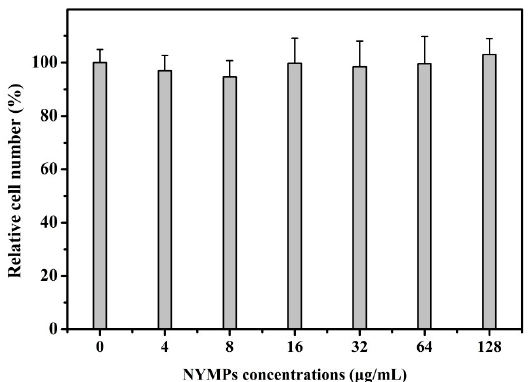
Figure 1. Cytotoxicity of water-soluble NYMPs on human breast cancer MCF-7 cells under different concentrations. Each value represents the mean ± standard deviation ( n = 3).